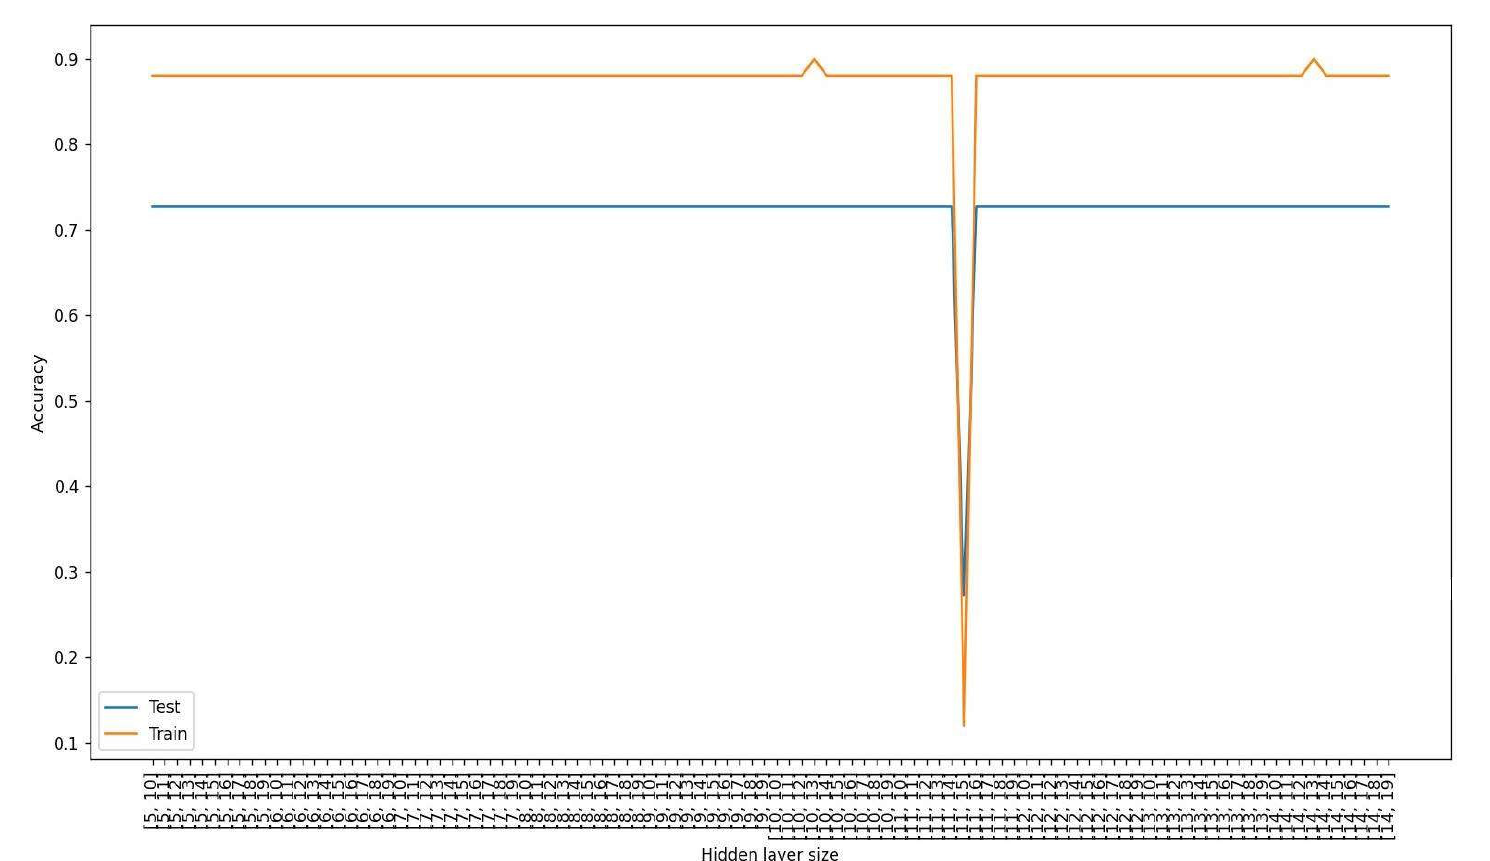
Figure 6. Accuracy of the MLP model (I = (5, 15), j = (10, 20)). Note: MSE = 0.083; Scores (Cross validation with cv = 5) = [0.8, 0.8, 0.857, 0.857, 0.857].